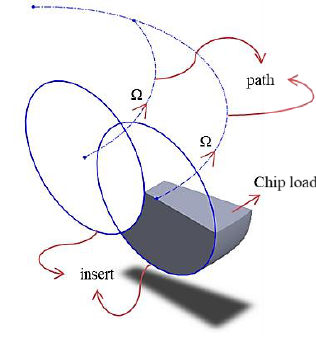
Figure 18. The three dimensional (3D) chip load in finish milling with a round insert.